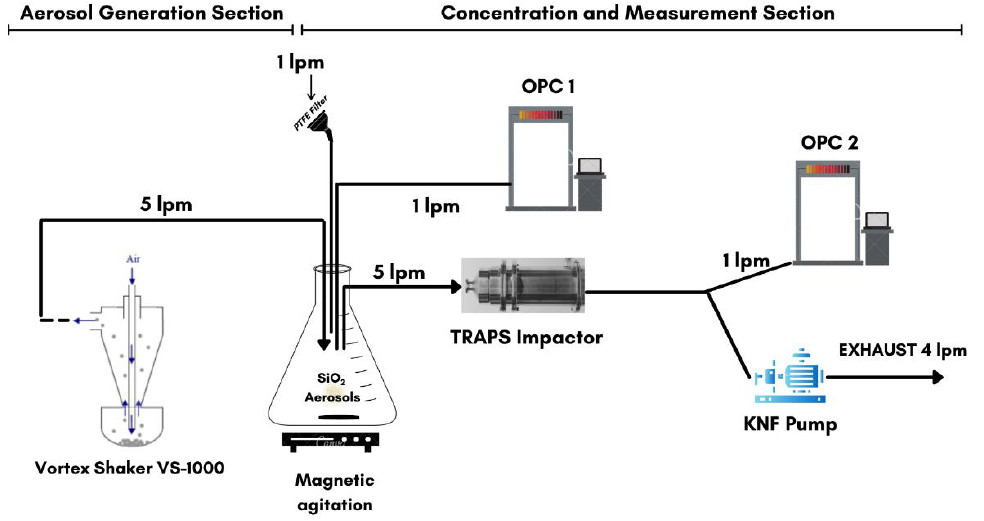
Figure 3. Schematic representation of the experimental setup for determining the coarse stage collection efficiency using vortex shaking of powders of monodisperse silica spheres.